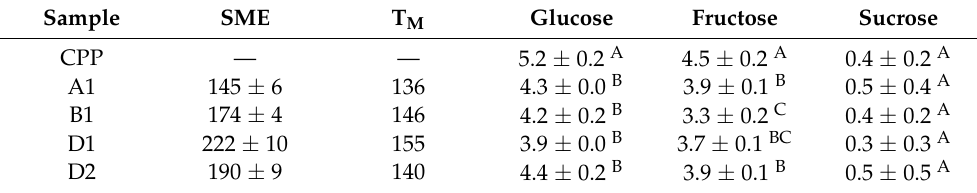
Table 5. Glucose, fructose, and sucrose contents of chokeberry pomace powder (CPP) before and after extrusion processing (g/100 g dm, mean ± SD, n = 2) at water contents of 13% (A1, B1, and D1) and